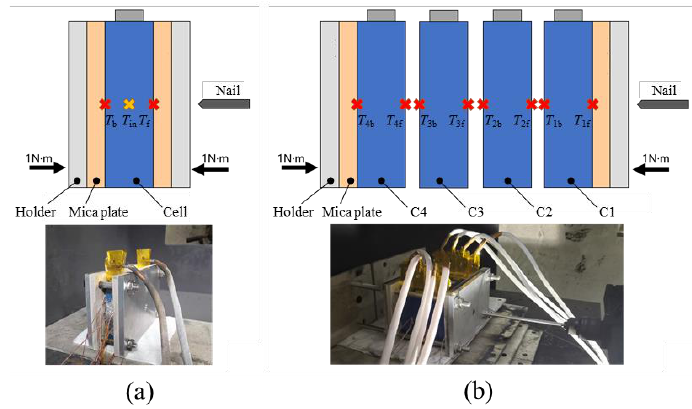
Figure 3. Nail-penetration abuse test. ( a ) cell test; ( b ) module test.